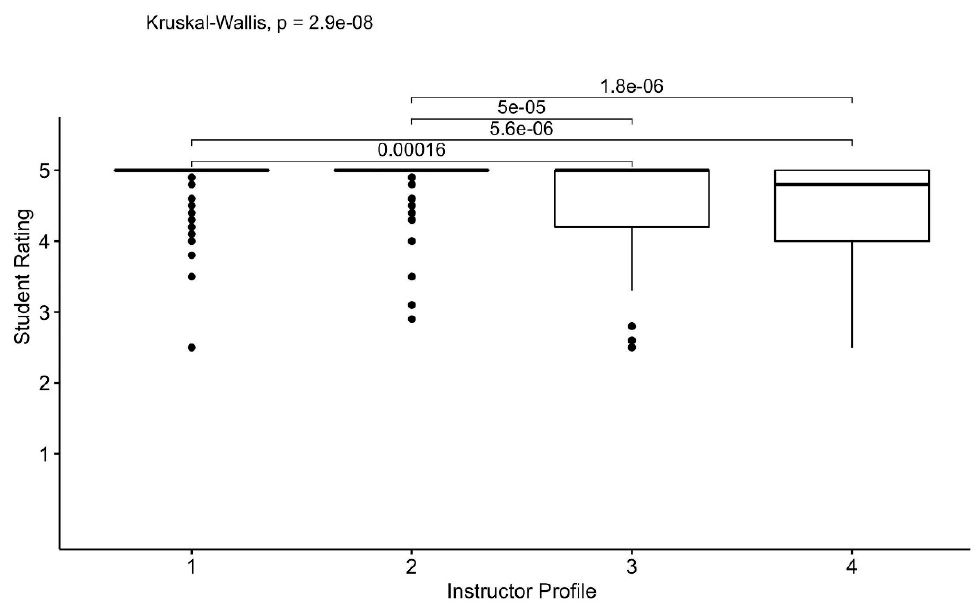
Figure 2. Respect for Spanish ratings according to instructor profile. Instructor 1 is a native speaker from Spain, Instructor 2 is a native speaker from Latin America, Instructor 3 is a Heritage Speaker of Spanish, and Instructor 4 is an L2 Spanish speaker.